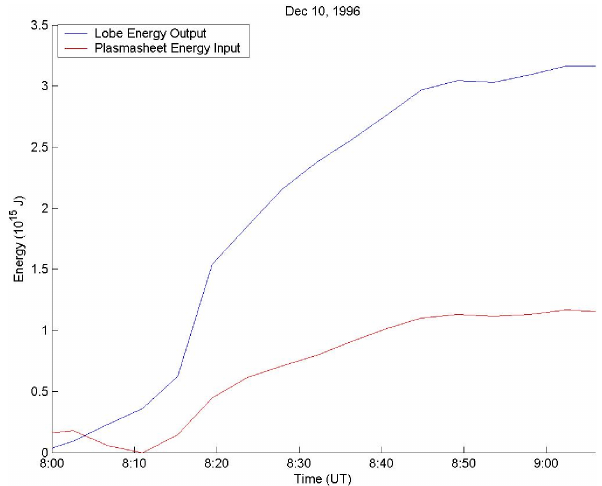
Fig. 7. The absolute amount of decrease in the lobes after the 10 December 1996 substorm onset and the absolute amount of increase of magnetic energy in the plasma sheet is shown. The ratio of the two is